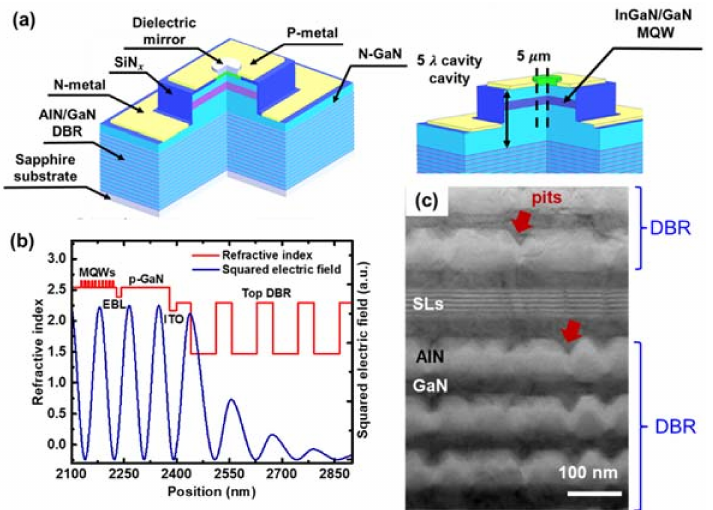
Figure 5. ( a ) Schematic structure and ( b ) optical mode intensity profile of first hybrid-type nitride VCSEL. ( c ) TEM observation of a defective area in AlN/GaN DBR. The epilayer structure for optical simulation of ( b ) followed the reference [12] (Data from